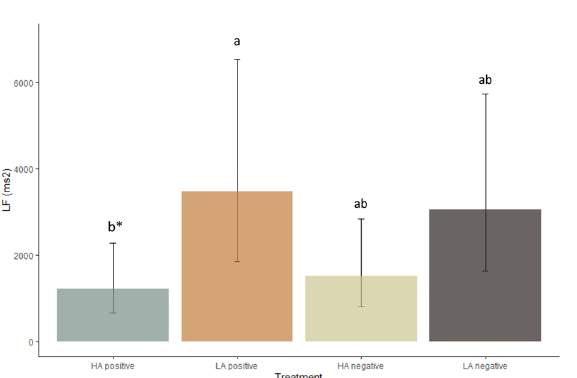
Figure 8. Effect of emotional treatment (Table 2) on heart rate variability indexes (mean ± CI), LF. HA high arousal, LA low arousal. Asterisk: bars that do not share the same letter tend to differ from each other (P <